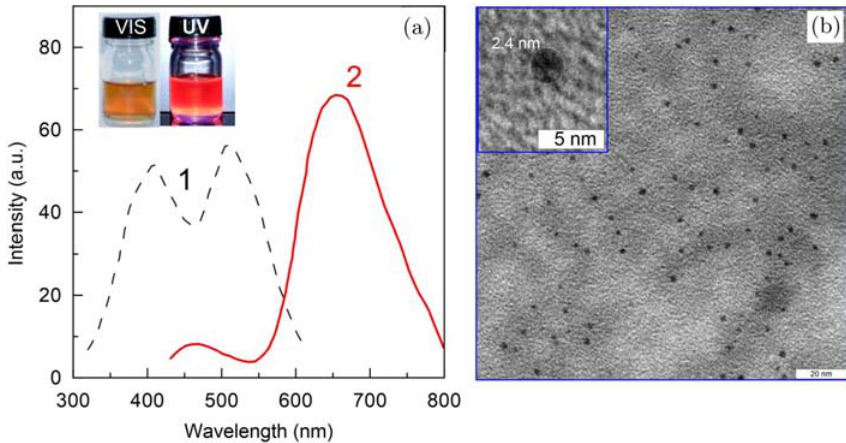
Fig. 1. (a) Excitation (1) and emission (2) spectra of the Au – HSA NCs. (b) TEM images of the Au – HSA NCs. The inset in panel (a) shows photos of NC solutions under white light (left) and UV light (right) irradiation. The inset in panel (b) shows a magni¯ed image of a single